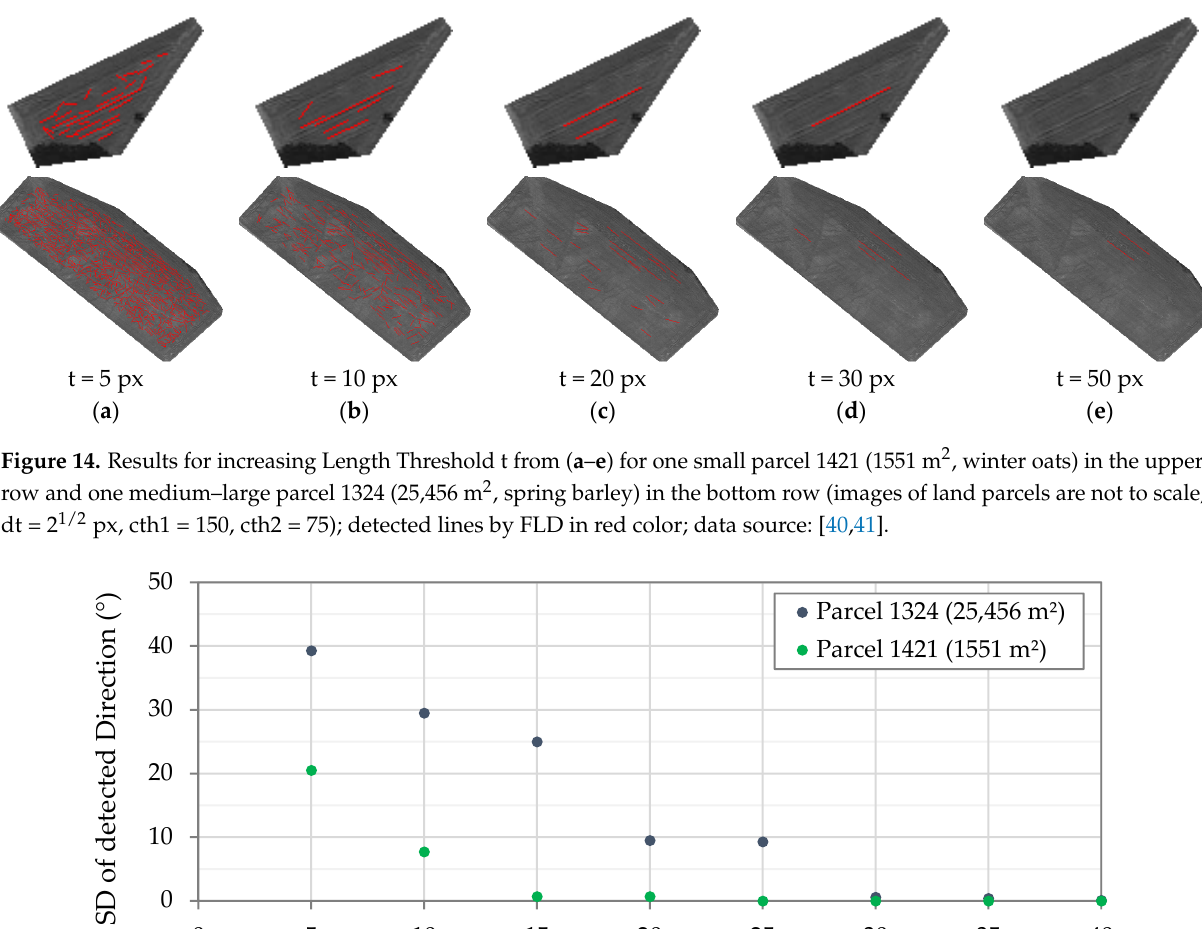
Figure 16. Calculation of Length Threshold t depending on the field area. However, this behavior of not detecting lines for large t values depends on the Dis- tance Threshold dt, among others. The smaller the threshold value for dt is, the more likely the detection of a line is interrupted. Figure 17 visualizes the bivariate relationship be- tween the combination of parameters t and dt exemplified on an image with spring barley (Parcel 1323). On the horizontal axis, dt increases from left to right. The value for t in- creases on the vertical axis from top to bottom.